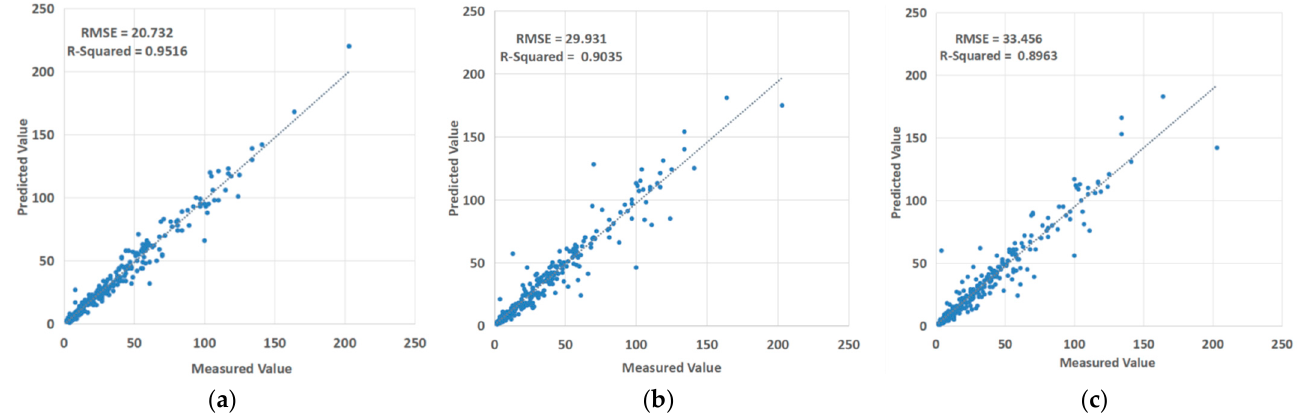
Figure 7. The performance of three models in predicting future 14 days from January to October 2022. ( a ) LSTM, ( b ) attention-LSTM, ( c ) our predictor.